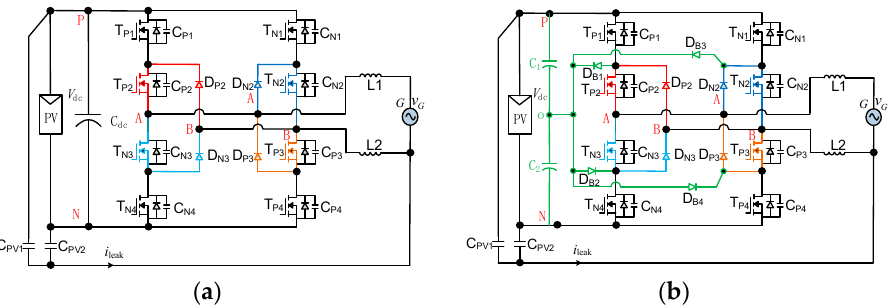
Figure 31. Topology H8 without /with NPC cell under DFUSPWM. ( a ) R13 (new); ( b ) R11S1 (new).